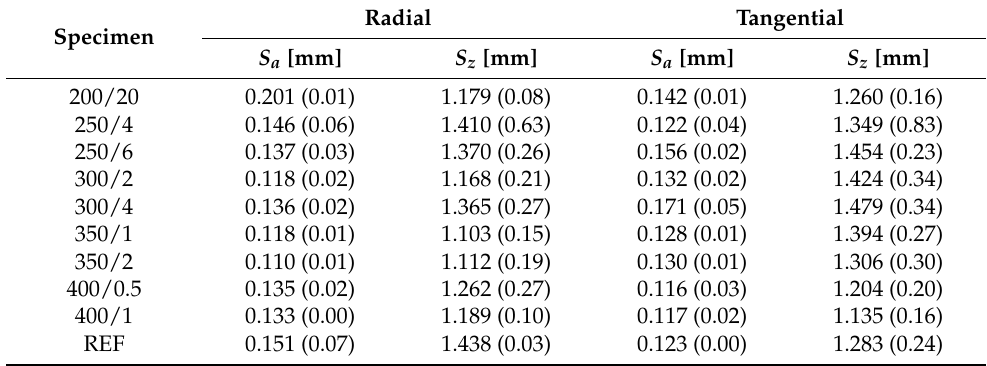
Table 2. Mean values of surface roughness and standard deviations for radial and tangential